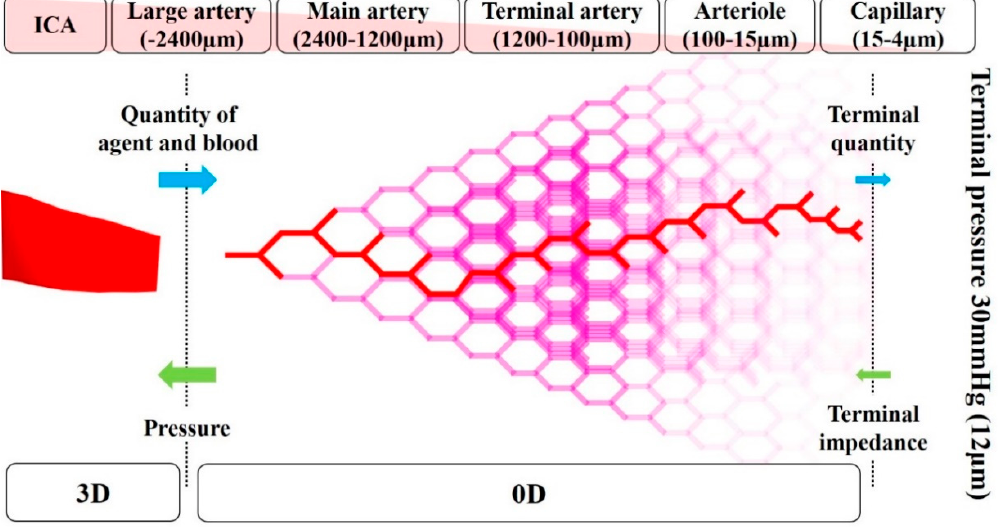
Figure 5. Conceptual diagram for the zero-dimensional resistance model.